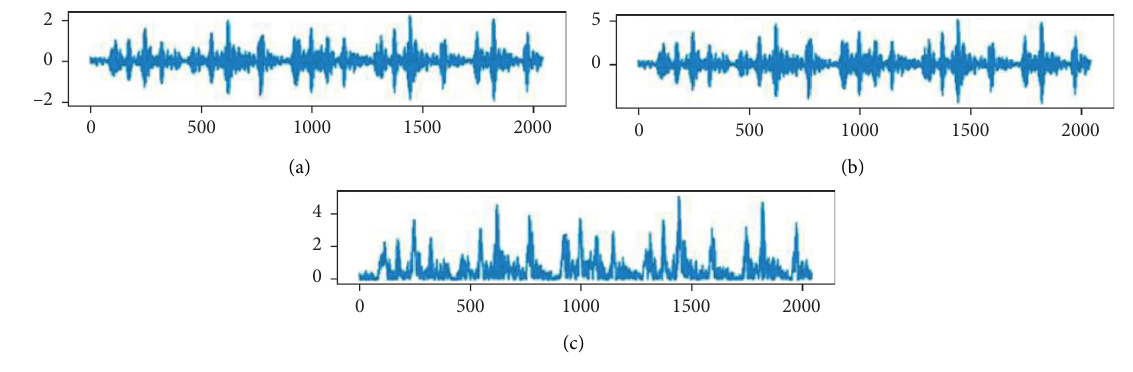
Figure 13: 0.021-inch IR